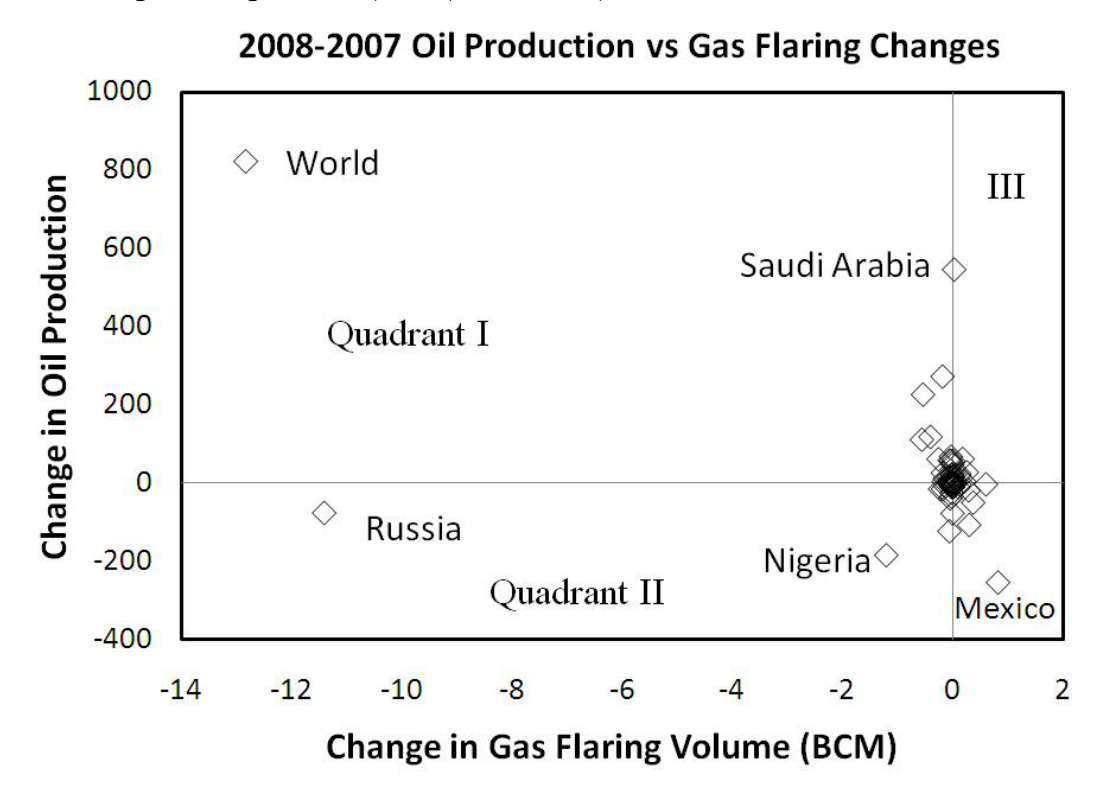
Figure 17. Changes in national and global flaring versus change in oil production from 2007 to 2008. In Quadrant I crude oil production increased while gas flaring declined. This includes the global total (World) plus the countries Angola, Iran, Iraq, and Kuwait. Saudi Arabia expanded their production by 7.5% while their flaring volume remained essentially unchanged. Quadrant II countries had reduced crude oil production and decreased gas flaring (Nigeria and Russia). Quadrant III countries had increased crude oil production and increased gas flaring. Quadrant IV countries had reduced crude oil production with an increase in gas flaring (Mexico, USA, Uzbekistan, and